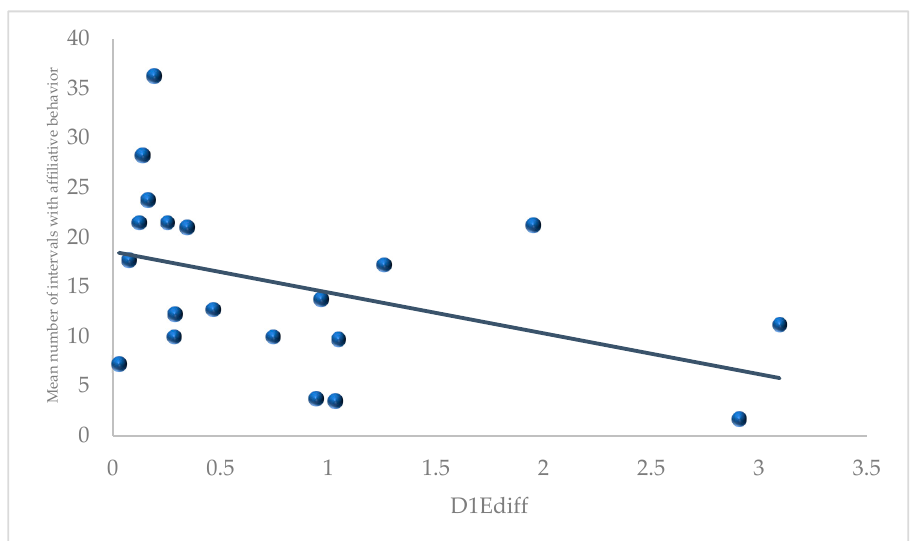
Figure 1. Correlation between difference in day 1 emotionality (D1Ediff) scores between social partners, measured in infancy and their mean number of intervals with observed affiliative behavior averaged across the protected and continuous full contact stages, measured in sub/adulthood (data are presented in the raw form).